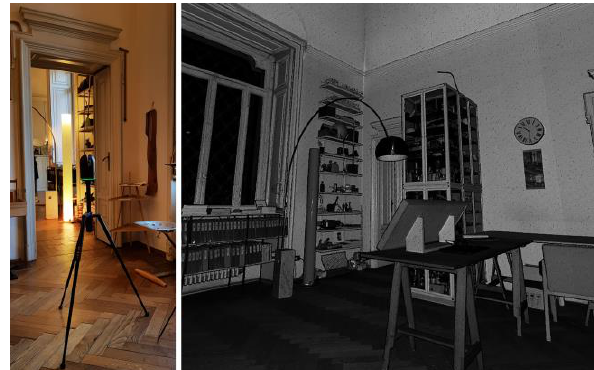
Figure 3. On the left, Leica BLK 360 laser scanner during surveying phases; on the right, view of the laser scanner point cloud.